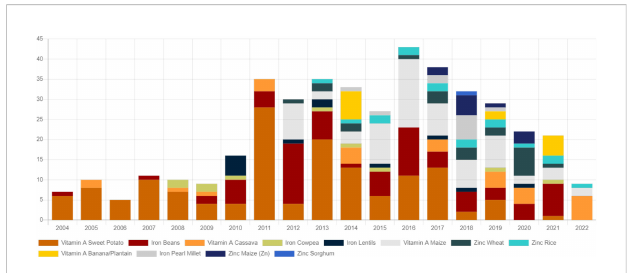
FIGURE 2 Nutrient-rich bred cultivars released in different crops for the last two decades (source: CGIAR HarvestPlus).